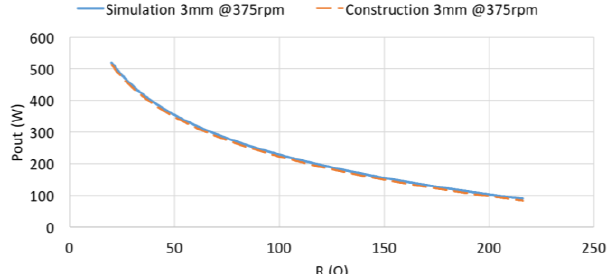
Figure 12. Plot versus the speed of the output power under 70, 26 and 130 Ω/phase load with 3 mm air gaps, experimental results. 4.4. Temperature Test A temperature test was performed before the construction of the rotors in order to check the safe operation of the machine. The crucial magnitude is the temperature of the stator, which consists of